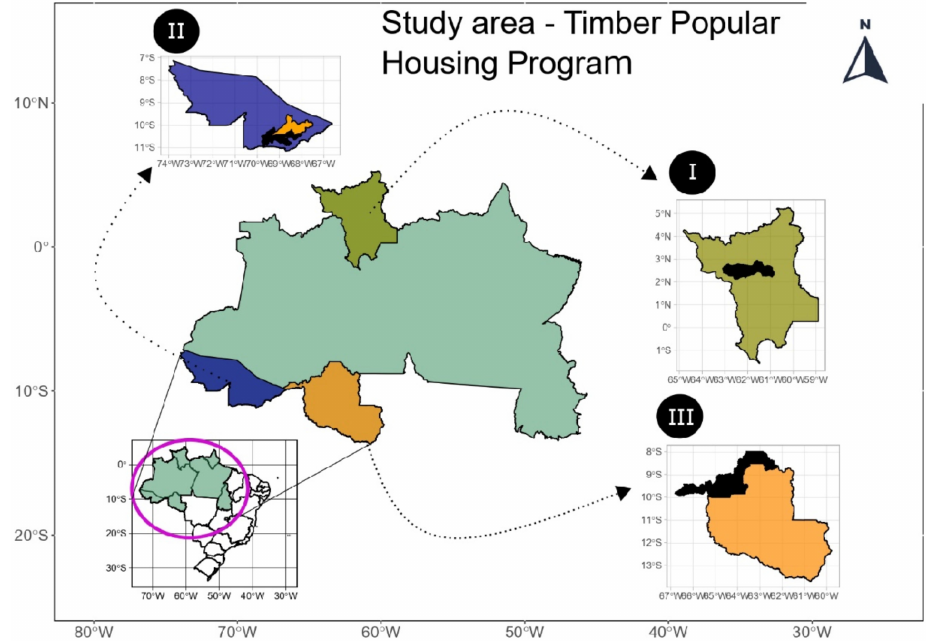
Figure 1. Affordable Wooden Housing Program in the Brazilian Amazon